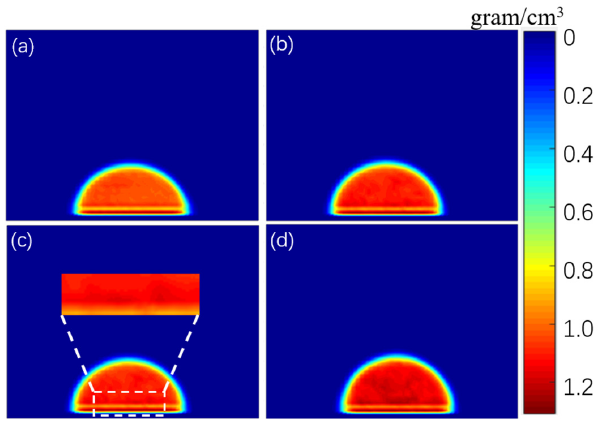
Figure 6. Density distribution of droplets with different NaCl concentrations, ( a ) 3%, ( b ) 6%, ( c ) 13.2%, and ( d ) 26%. and ( d )